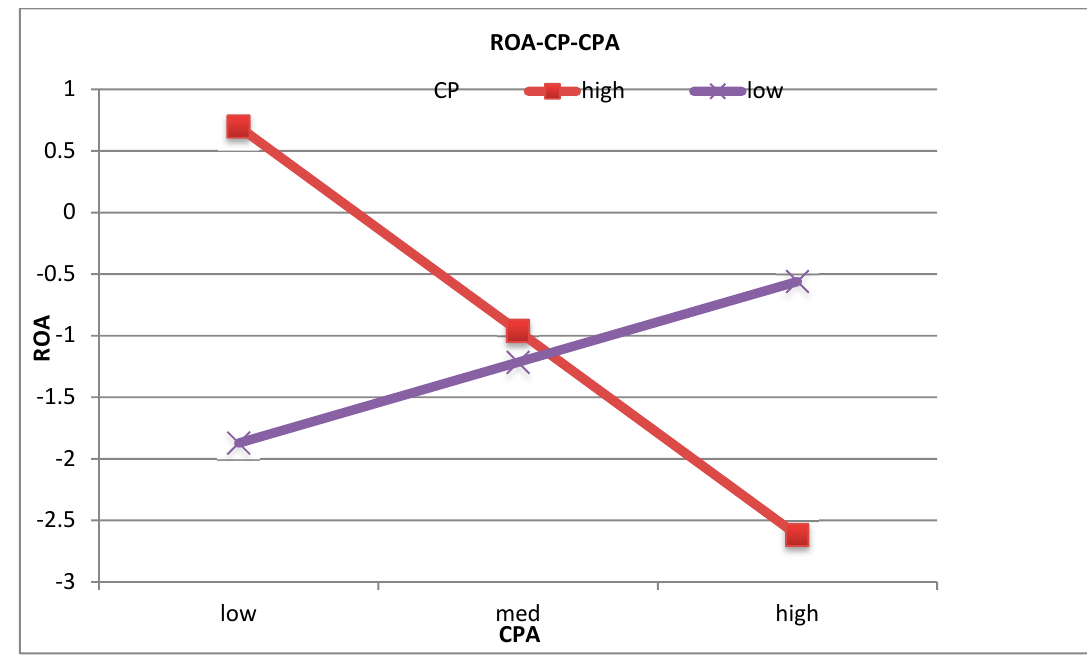
Figure 2. Effects of CPA on ROA: Contingent on CP.